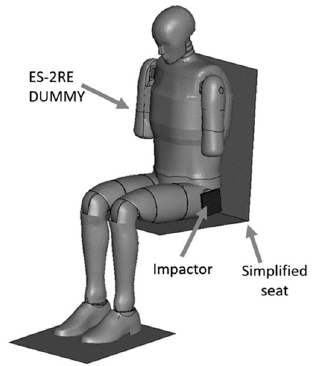
Figure 11. Modelled measurement station consisting of a dummy, seat and impactor.